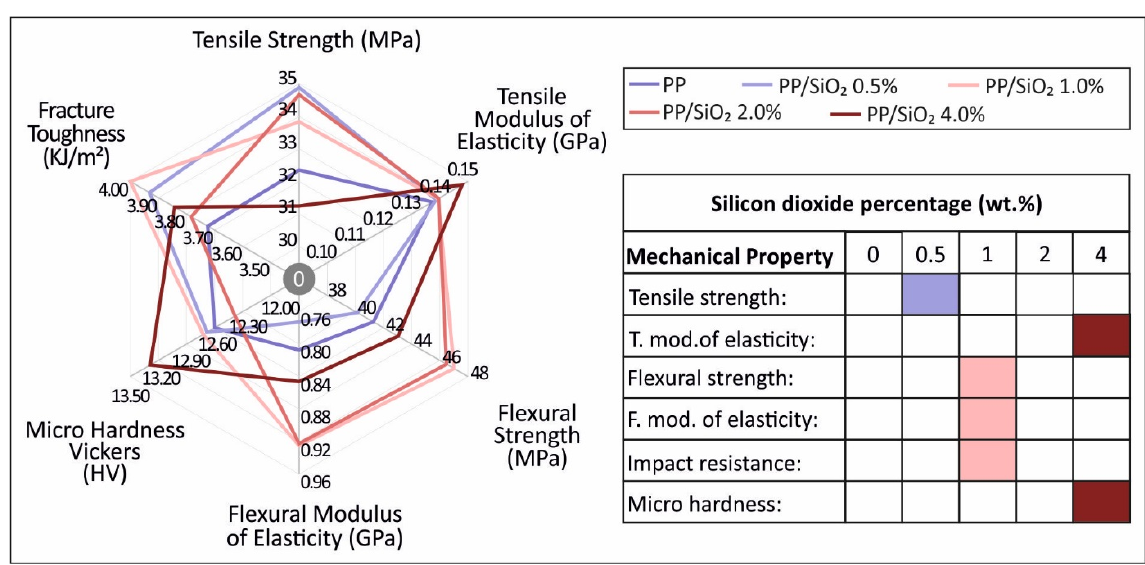
Figure 12. Summary of the mechanical properties measured and/or calculated through the conducted tests. Highest values marked at bottom right side for each material tested for the purposes of current study.